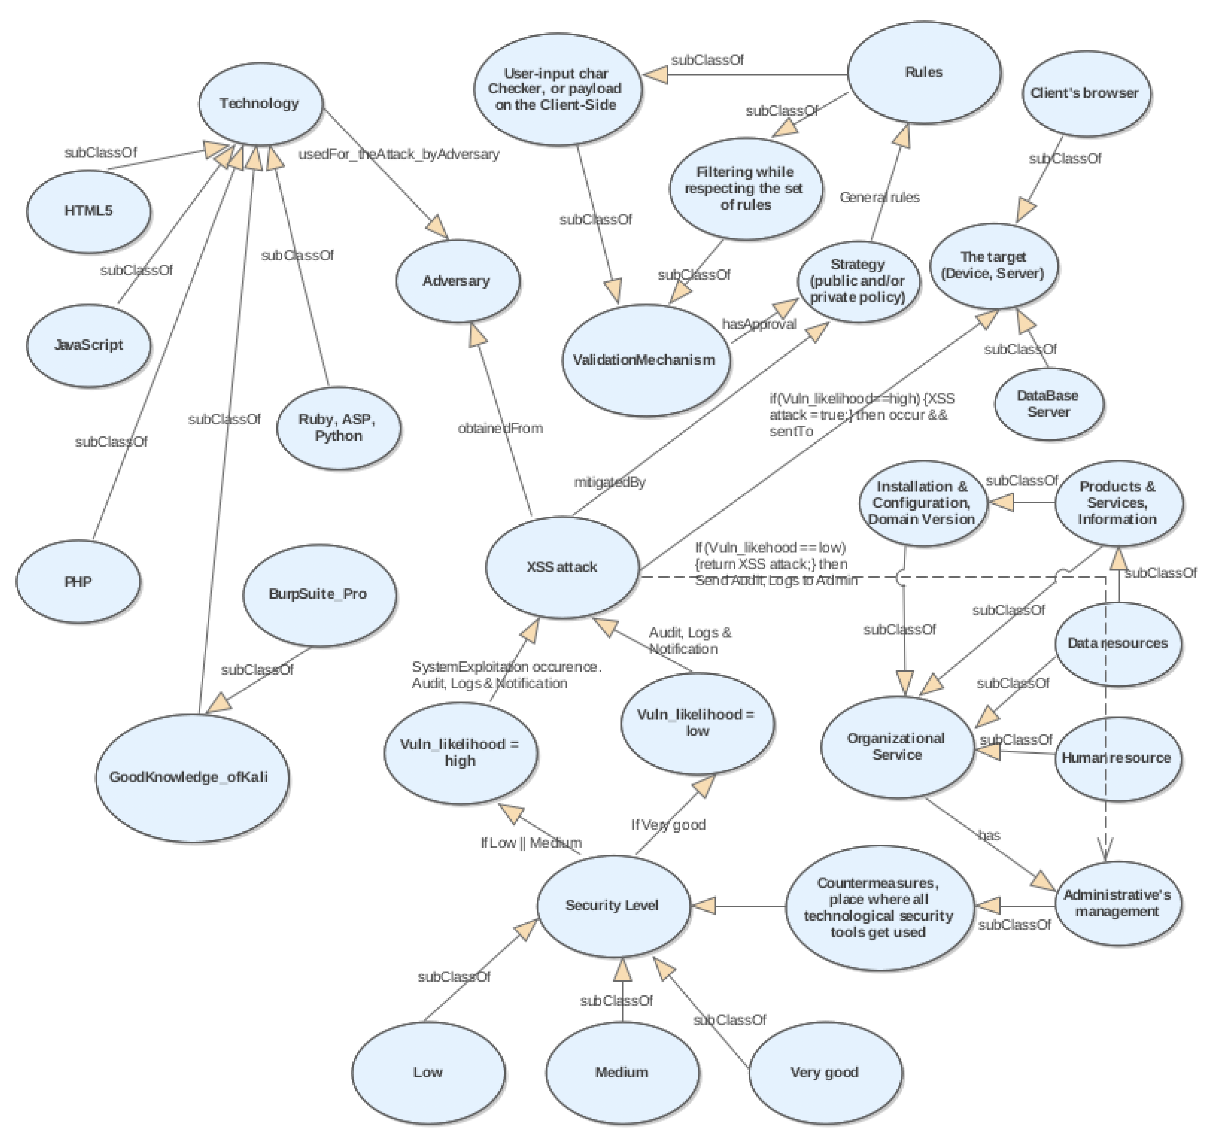
Figure 7. Our proposed ontology scheme for XSS attacks in